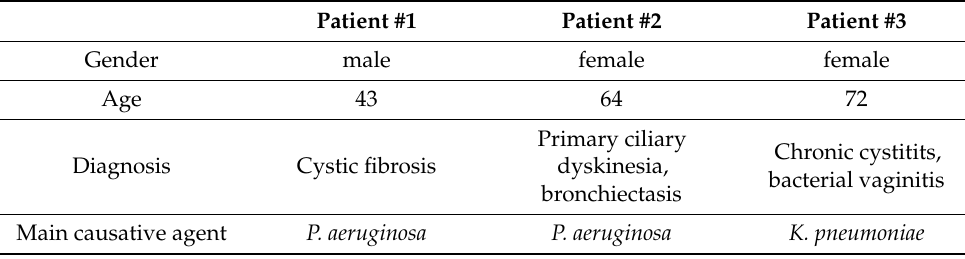
Table 5. A short summary of three patient cases and their treatment plans discussed in this